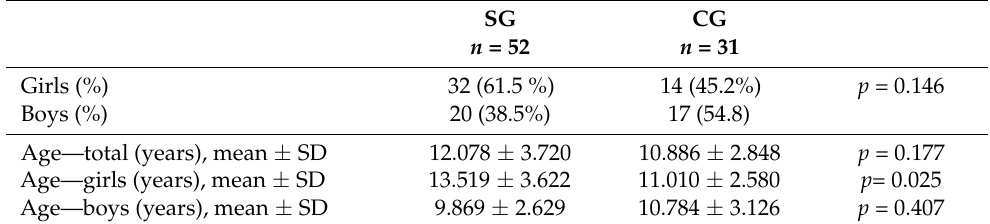
Table 1. Characteristics of the study group (SG) and control group (CG).